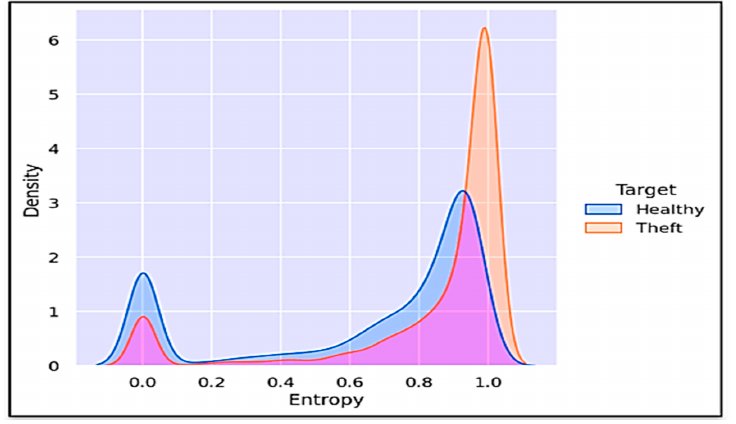
Figure 19. KDE plot of computed entropy values from consumers’ consumption data.